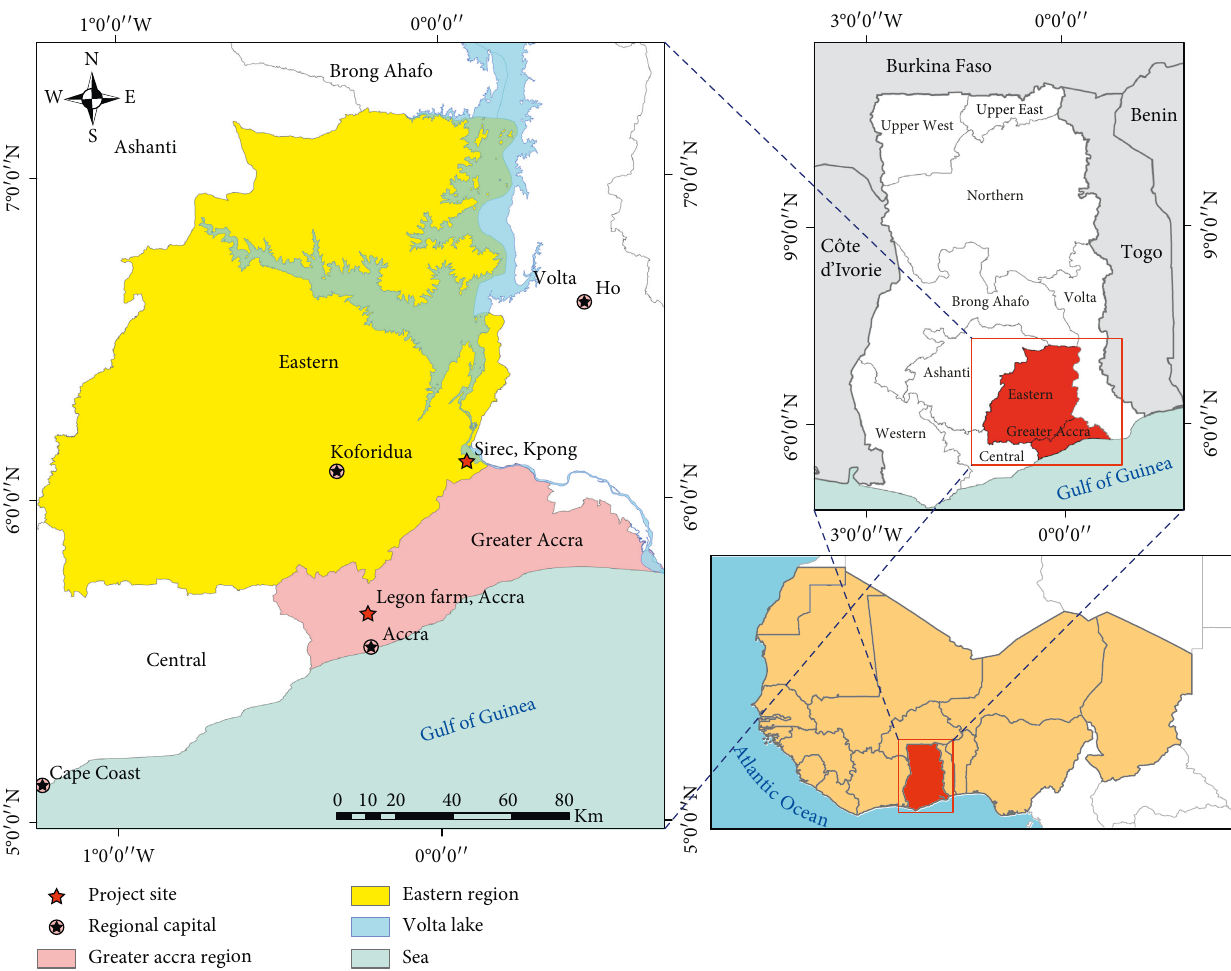
Figure 1: Map of Ghana showing study areas: SIREC-Kpong and University of Ghana main campus, Legon-Accra.